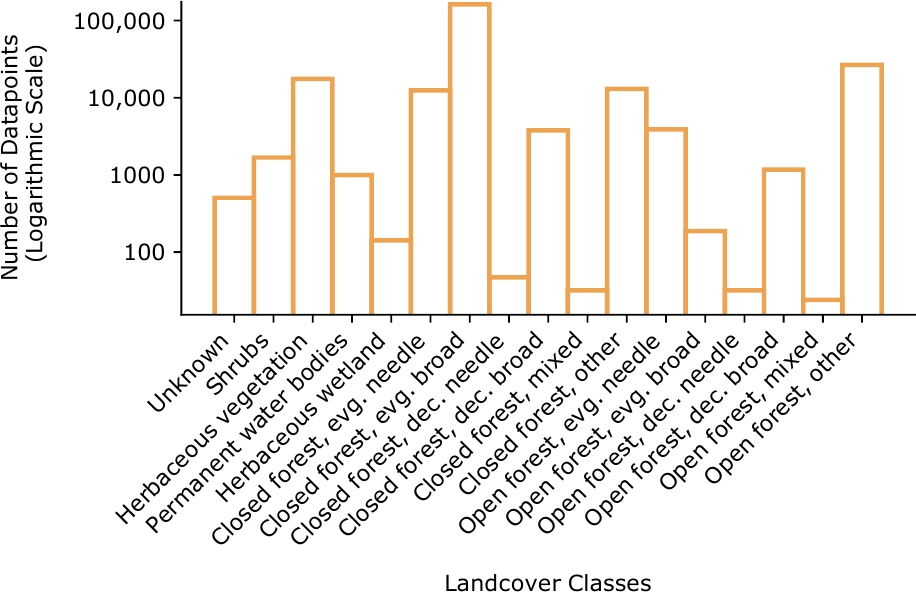
Figure 5. Distribution of data points of the whole dataset combined from all study regions per target class Fire and land cover class on a logarithmic